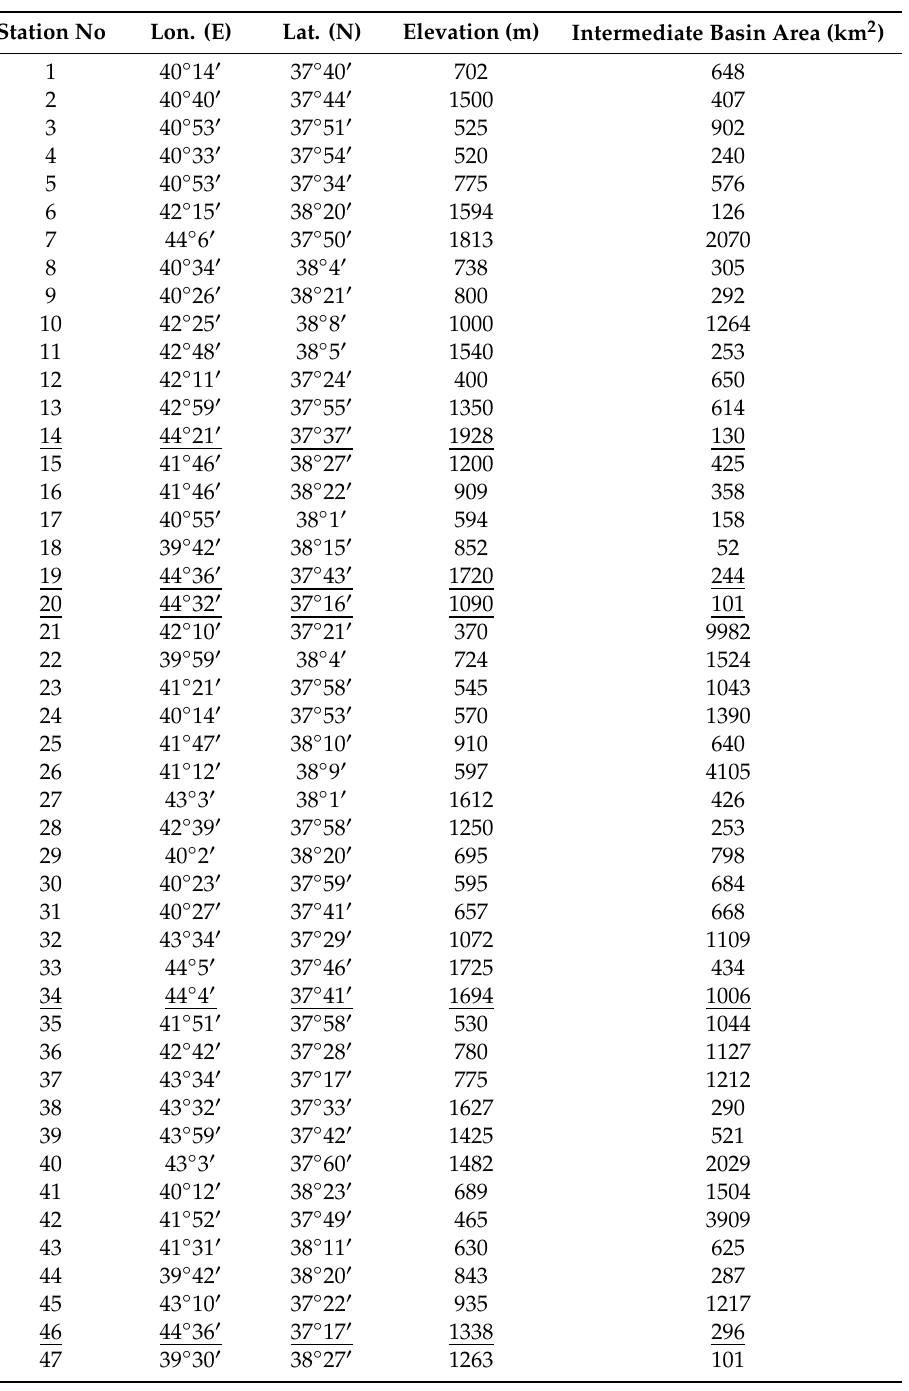
Table 1. Details of the hydrometric stations, coordinates, elevations, and intermediate basin areas (all the stations except the underlined ones are